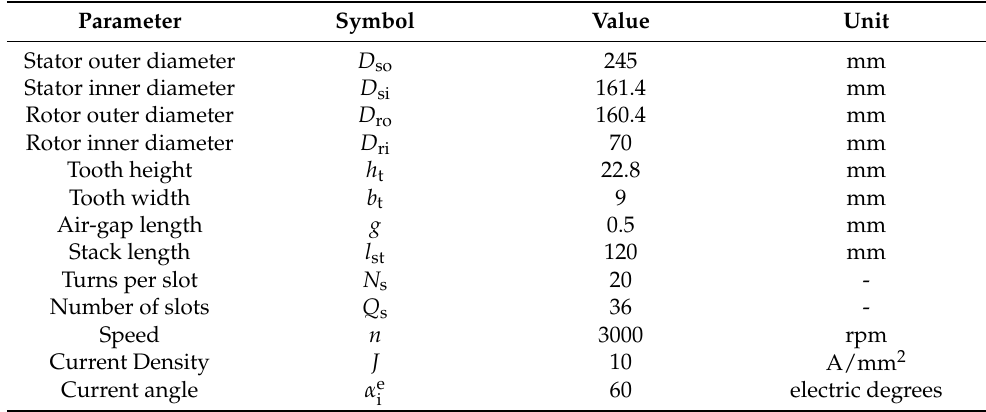
Table 1. Main data of the selected machines.